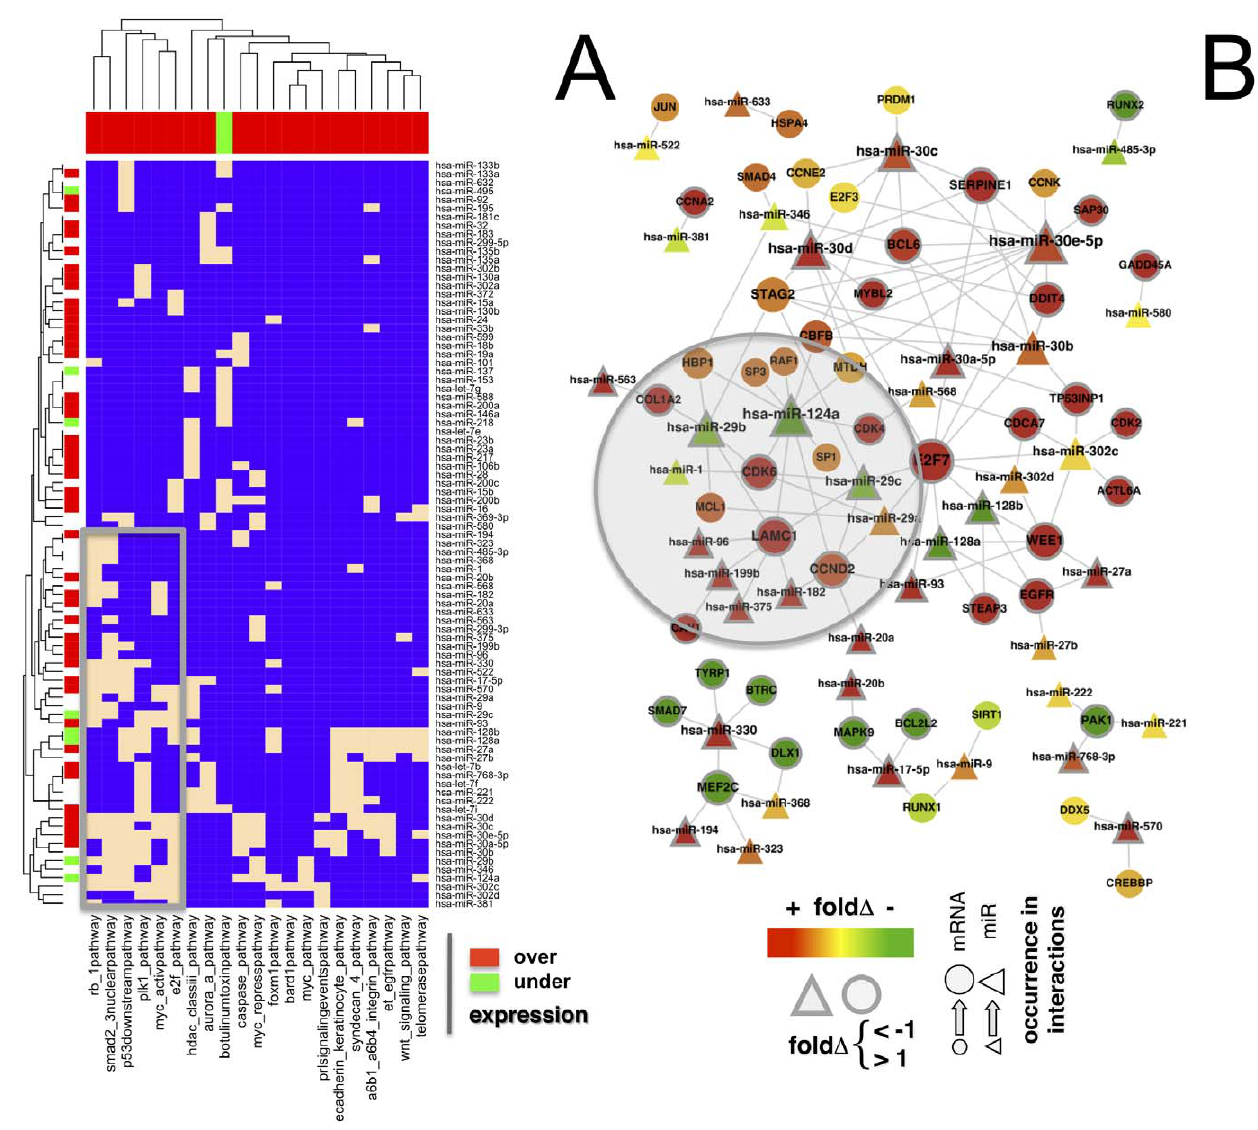
Figure 3. Significantly associated miRs in signaling pathways. ( A ) Utilizing all significant associations between 128 miRs and 246 genes, we constructed a bipartite matrix between miRs and signaling pathways that are over(under)-expressed in human GBMs. We established a link if the sets of genes in a pathway overlapped with mRNAs that are associated with a certain miR. Specifically, we found 21 pathways that are largely over- expressed in GBMs and 87 miRs. While a majority of miRs ware over-expressed (expression fold change FC . 1), we found a small minority of miRs that was under-expressed in GBMs (FC ,2 1). In particular, we highlighted a small cluster that pooled most of the under-expressed miRs and prominent pathways such as the p53 downstream and myc activation pathway (box). In ( B ) we mapped all interactions between associated miRs and genes that appeared in the corresponding pathways. Confirming our predictions, we found significant interactions between genes of the extracellular matrix and miR-29bc and -124a that have been previously implicated in glioblastomas and other cancer types (shaded area). Furthermore, miR-124a was previously reported as a regulator of CDK6 in GBMs.